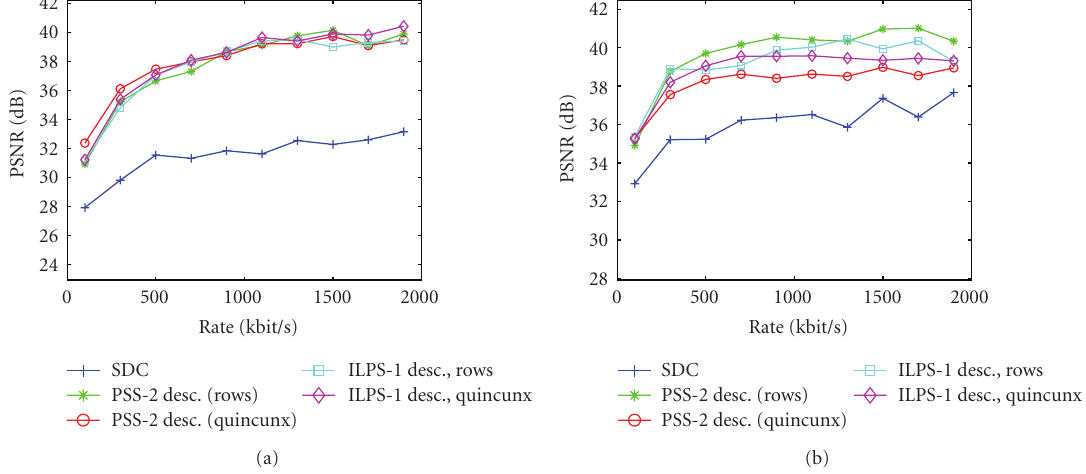
Figure 14: Performance of color view, two subsequences received, 10% packet loss. (a) Breakdance. (b) Ballet.